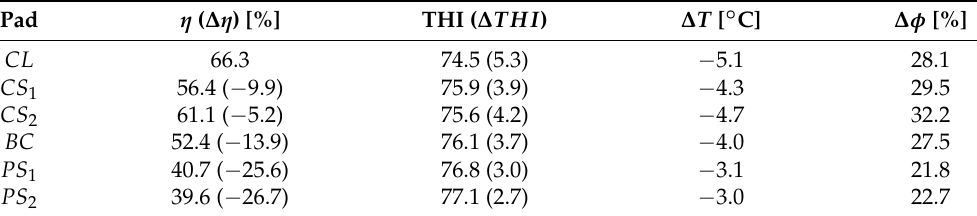
Table 9. Cooling efficiency ( η ), Temperature–Humidity Index (THI), dry-bulb temperature drop ( ∆ T ) and relative humidity increment ( ∆ φ ) for average input variables: inlet air velocity ( u = 1.5 m s − 1 ), pad thickness ( L = 0.1 m), dry-bulb temperature ( T db = 30 ◦ C) and relative humidity of inlet air i